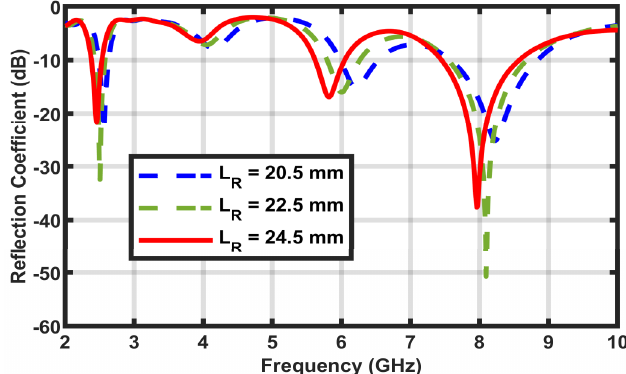
Figure 5. Effect of varying the length of left stub.